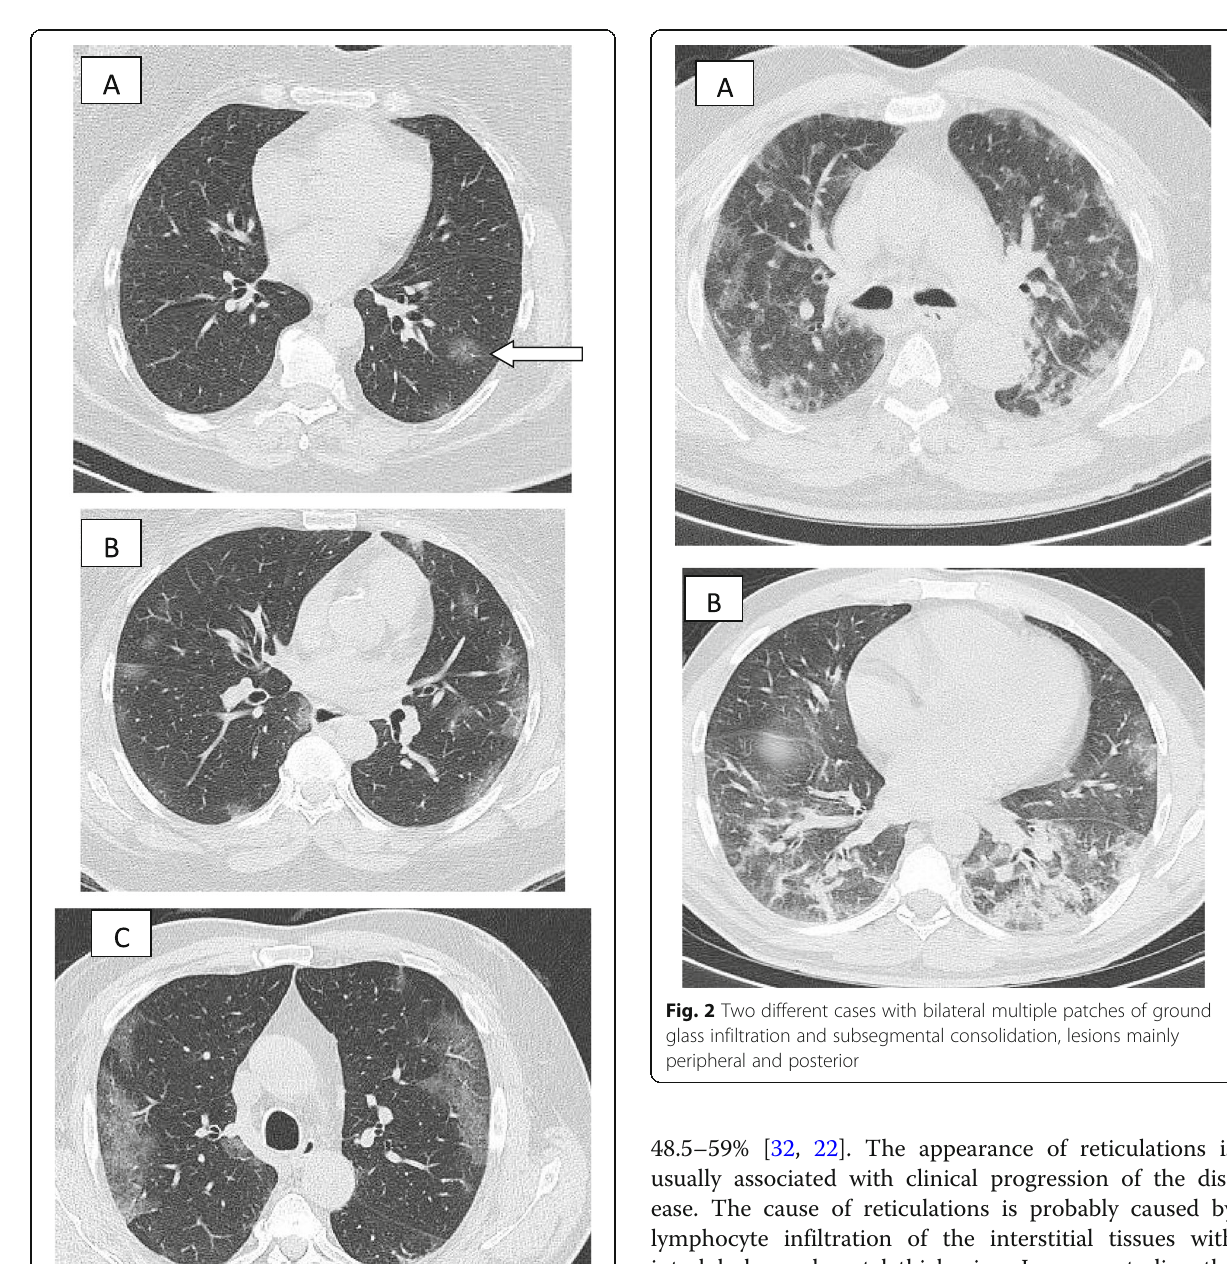
48.5 – 59% [32, 22]. The appearance of reticulations is usually associated with clinical progression of the dis- ease. The cause of reticulations is probably caused by lymphocyte infiltration of the interstitial tissues with interlobular and septal thickening. In some studies, the reticular pattern was a common pattern, considered the third common sign after GGO and consolidation [22] (Fig. 8). Crazy paving sign The crazy paving signs represent thickened interlobular septa superimposed on GGO. This sign represents alveo- lar edema and interstitial inflammatory reaction [45, 47]. In the meta-analysis of Bao et al. [18], the crazy paving sign had incidence of 14.81% (95% CI 6.61 – 25.99%). On the other hand, some articles reported higher incidence like study performed by Guan et al. [37], who reported